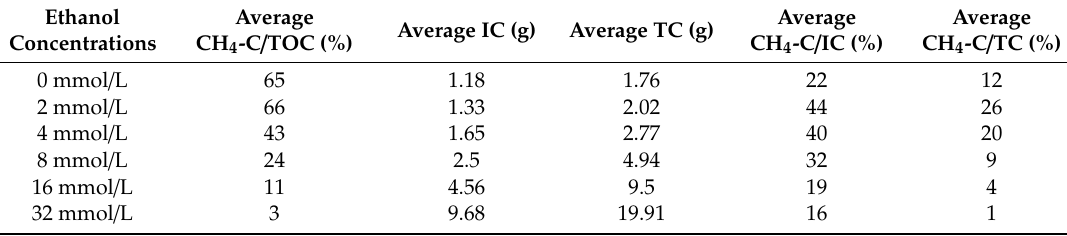
Table 4. The share (%) of the CH 4 emission factors in the initial loading in the